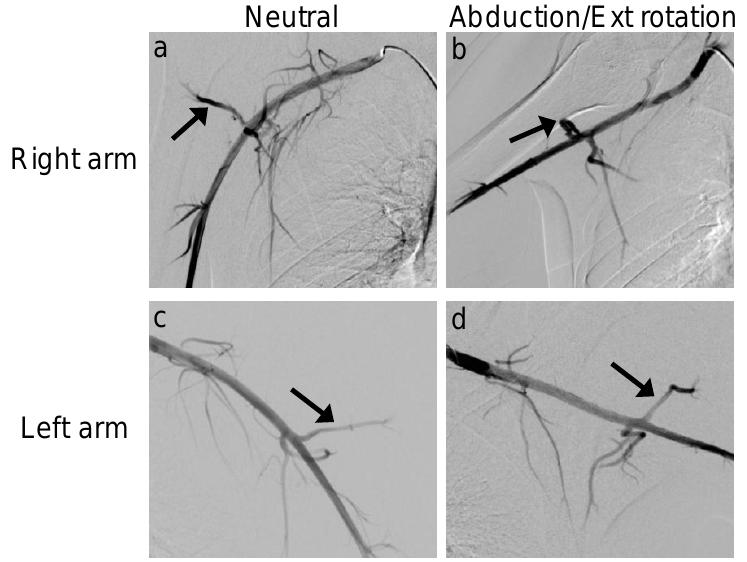
Figure 3. A 27-year-old right hand-dominant man presented with right shoulder pain and weakness, which had been nonresponsive to conservative measures. His pain was located in the right posterior shoulder with point tenderness directly over the quadrilateral space. This pain was aggravated by abduction and external and internal rotation. Following clinical examination, bilateral upper extremity arteriography was performed in neutral position and following provocative maneuvers. Bilateral provocative digital subtraction angiography of posterior humeral circumflex artery (PHCA) in patient with chronic right-sided shoulder pain. ( a ) Arrow pointing to normal flow of right PHCA with patient in neutral, supine position. ( b ) Arrow pointing to external compression of right PHCA following abduction and external (Ext) rotation of right shoulder. ( c ) Arrow pointing to normal flow of left PHCA with patient in neural, supine position. ( d ) Arrow pointing to normal flow of left PHCA following abduction and external rotation of left